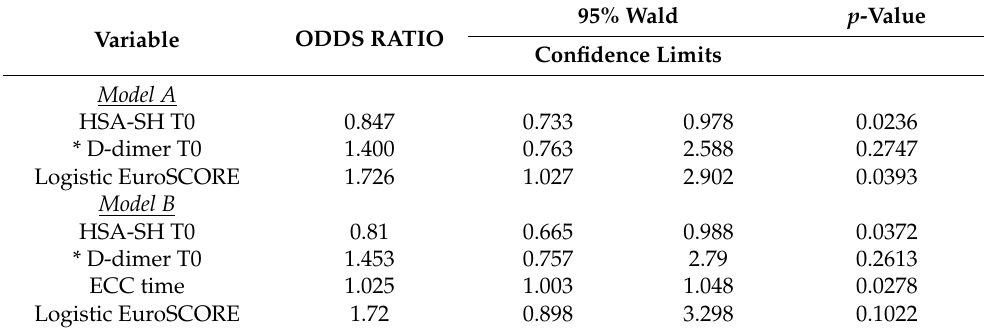
Table 3. Logistic models for HSA-SH association with graft occlusion at 5 years